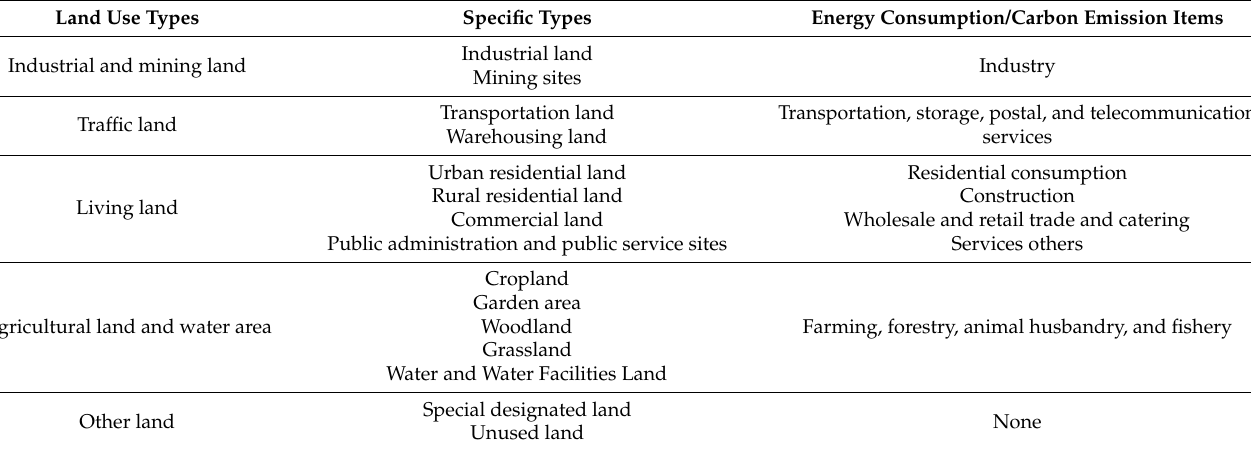
Table 1. Relationship between land use types and energy-related carbon emission